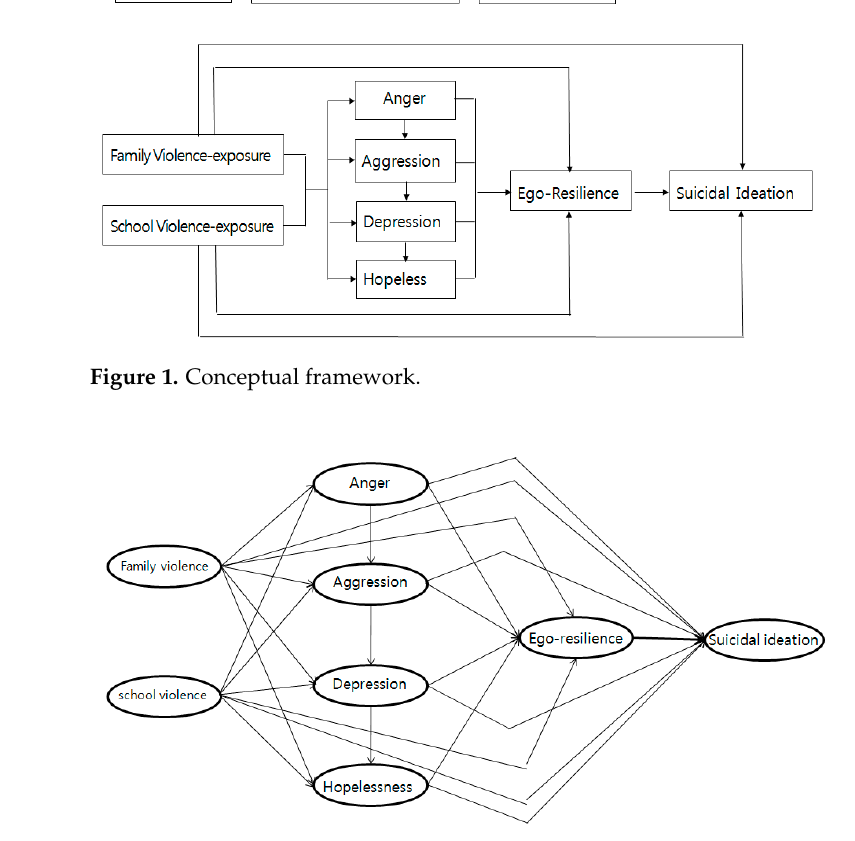
Figure 2. Hypothetical model.